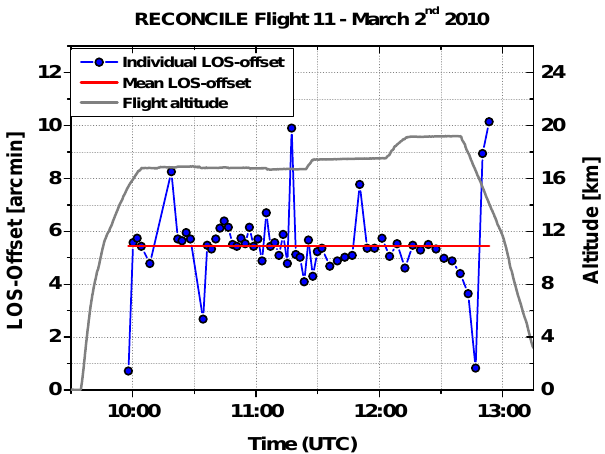
Fig. 12. Retrieved LOS offsets from the individual limb sequences and mean LOS offset used as LOS